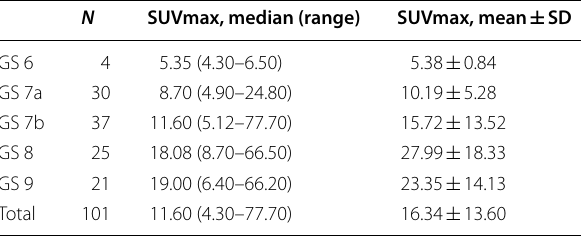
Table 1 Patient characteristics